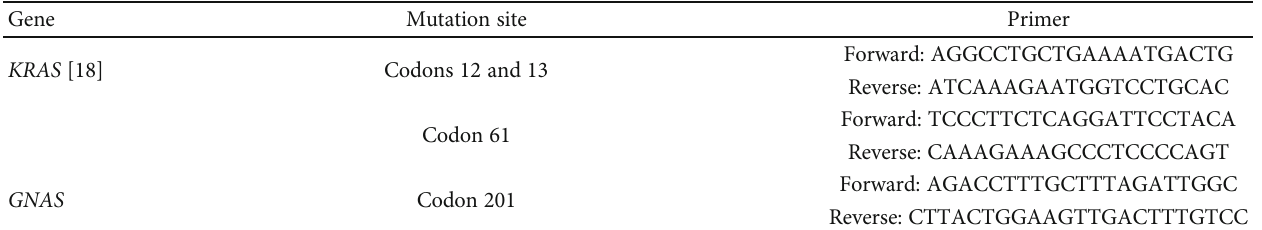
Table 1: PCR primers used for PCR ampli fi cation and Sanger